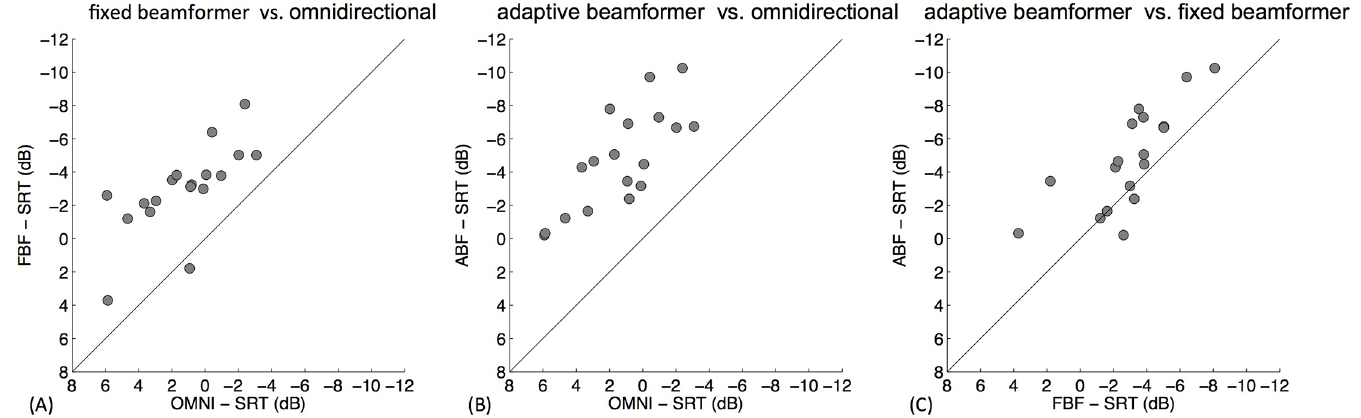
Fig 4. Individual differences in terms of SRT for each subject. (A) Fixed beamformer (FBF) vs. Omnidirectional microphone (OMNI), (B) Adaptive Beamformer (ABF) vs. OMNI, and (C) ABF vs. FBF.